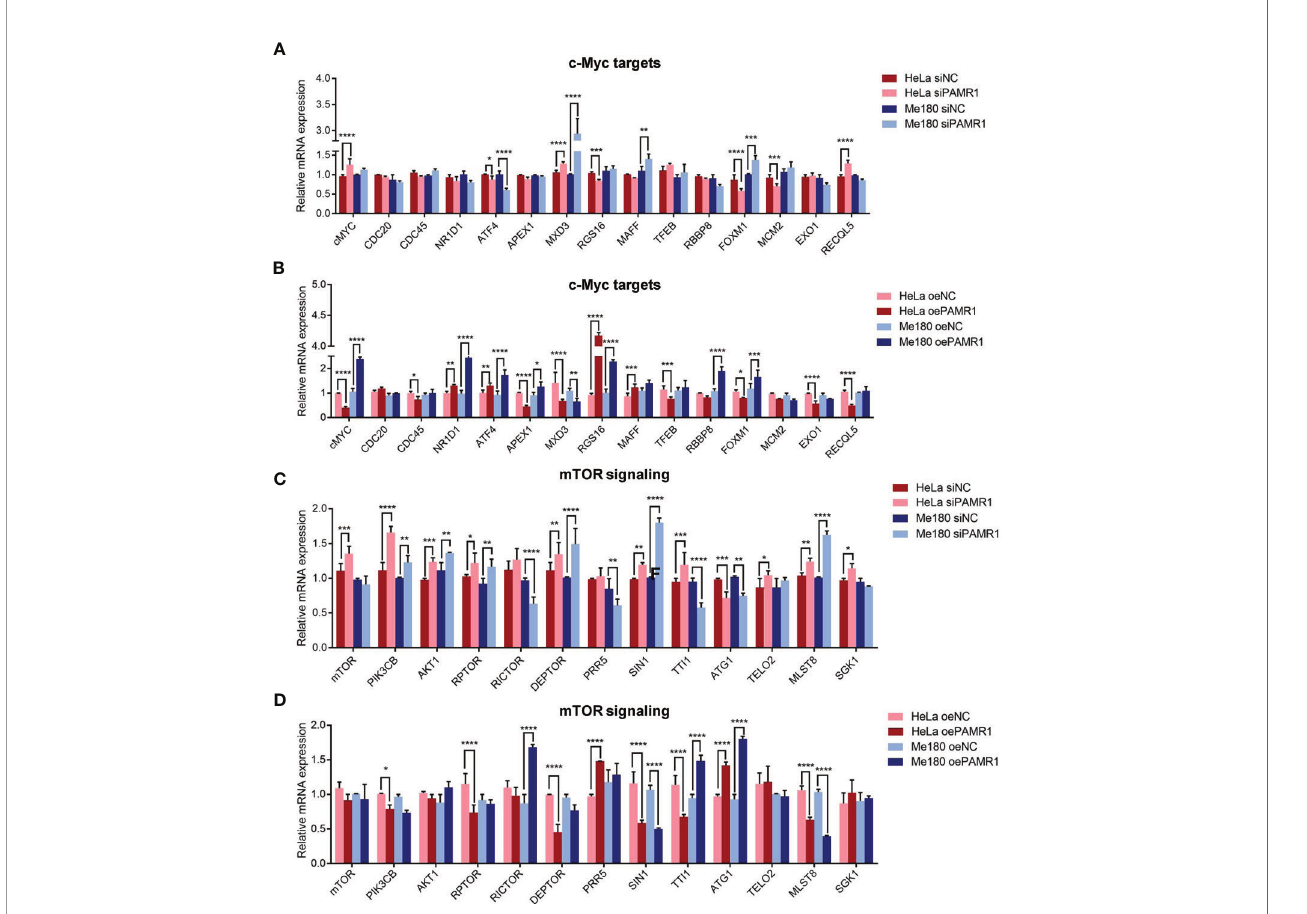
FIGURE 5 | PAMR1 regulated MYC target and mTORC1 signaling pathways. qRT-PCR analyzed the expression of core genes in the MYC target signaling with downregulation (A) or upregulation (B) of PAMR1. qRT-PCR analyzed the core genes expression in mTORC1 signaling pathway with downregulation (C) or upregulation (D) of PAMR1. * p < 0.05, ** p < 0.005, *** p < 0.0005, **** p <